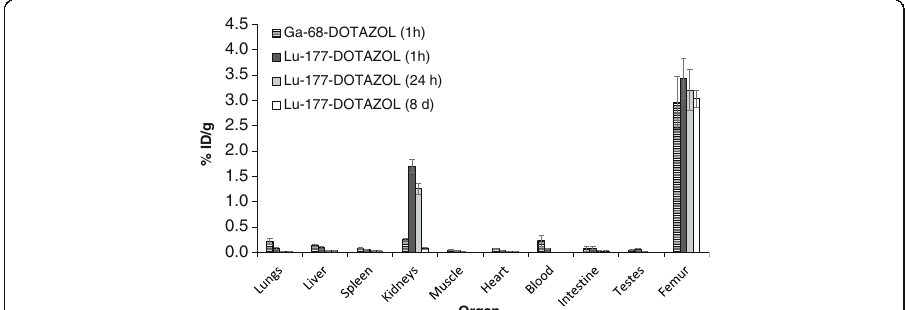
Fig. 4 The graph represents the results from the ex vivo organ distribution of the 68 Ga- and 177 Lu- complexes of DOTA ZOL in percent injected dose per